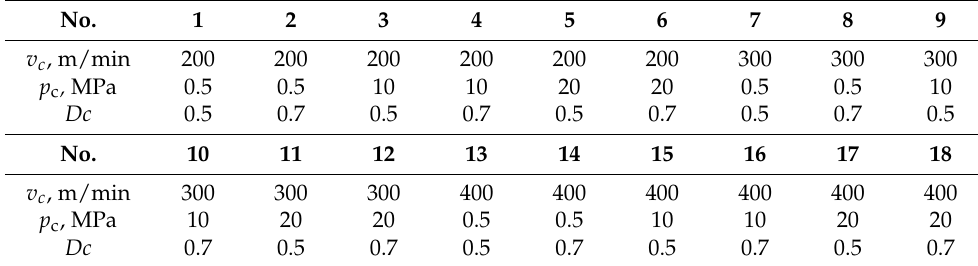
Table 3. Experimental setup for HUVC machining of Ti-6Al-4V.